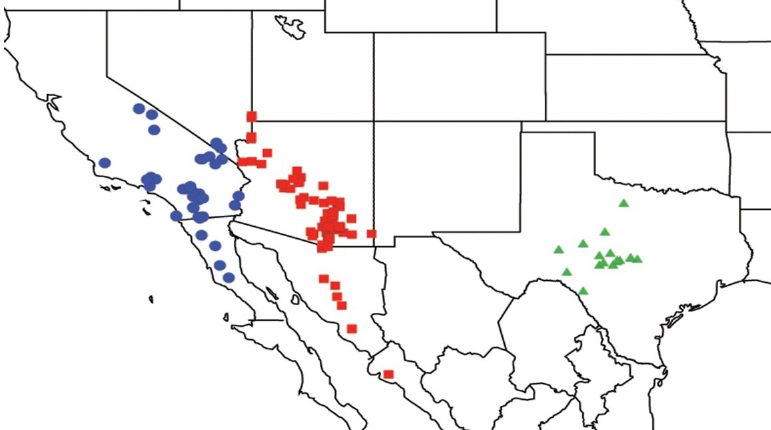
Figure 2. Distribution of Cacama californica (blue circles), C. moorei (red squares) and C. collinaplaga (green